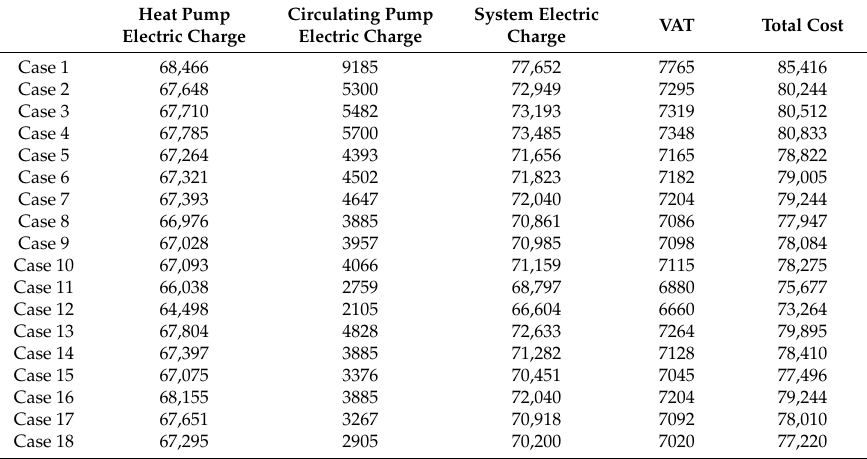
Table 10. Total operation cost of heating system for each case (Unit: